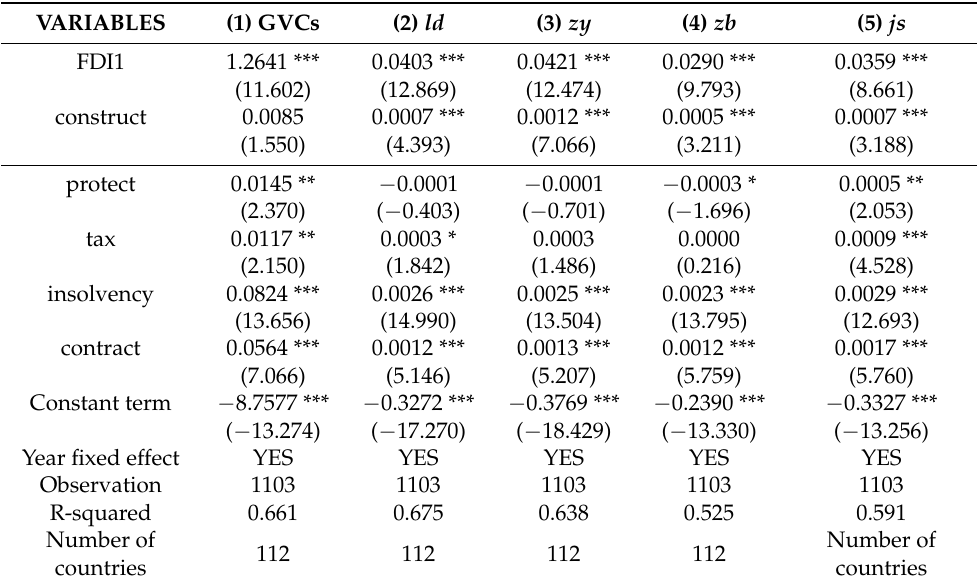
Table 5. Robustness